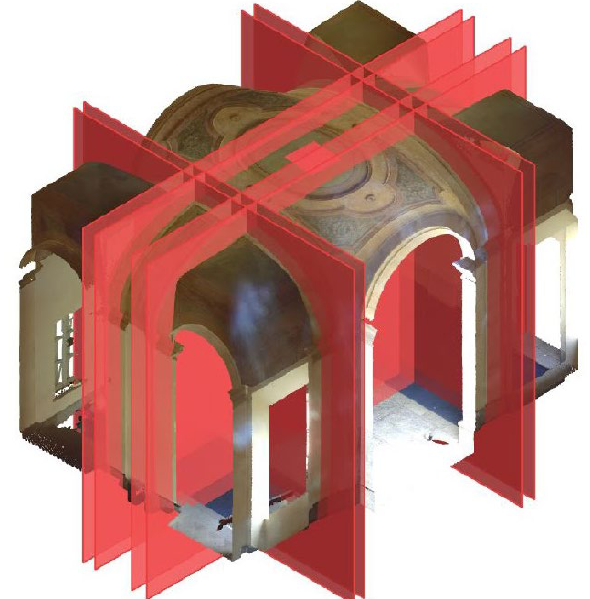
Figure 8 . Section plans on point cloud (Processing: F. Natta).